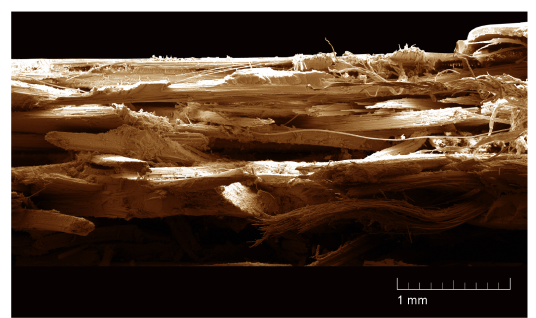
Figure 1. Detail of damage structure after tensile test obtained by scanning electron